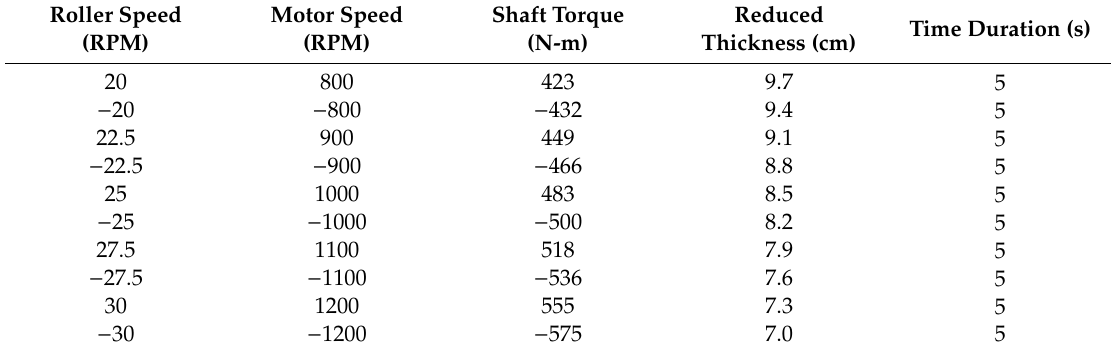
Table 3. Profile values of speed and torque (operation: 10